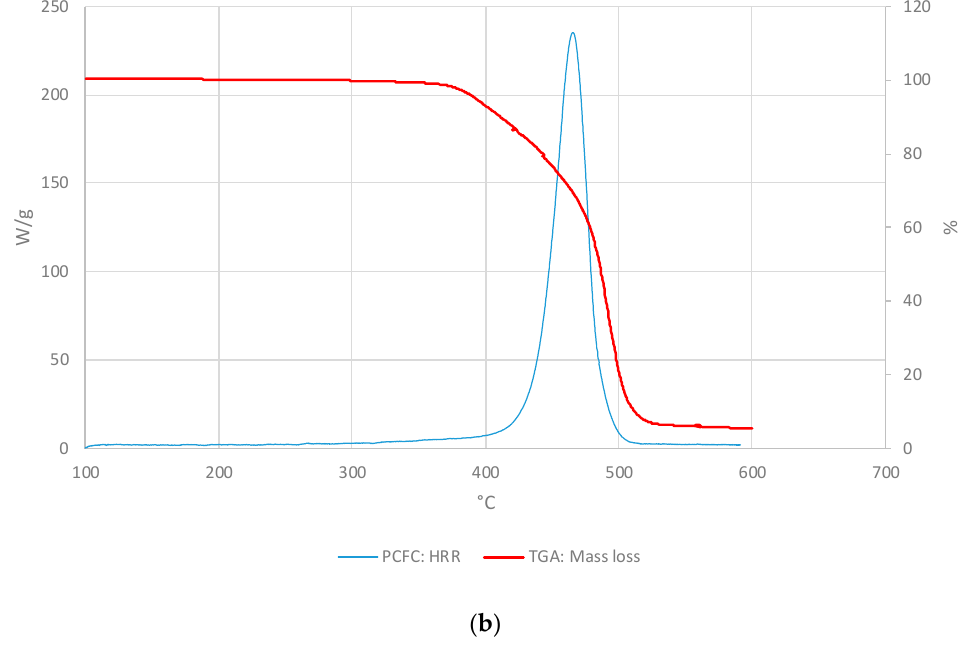
Figure 3. The heat release rate (HRR) (W / g) and mass loss (wt.%) curves for: ( a ) Façade type 1 material; ( b ) Façade type 2 material.